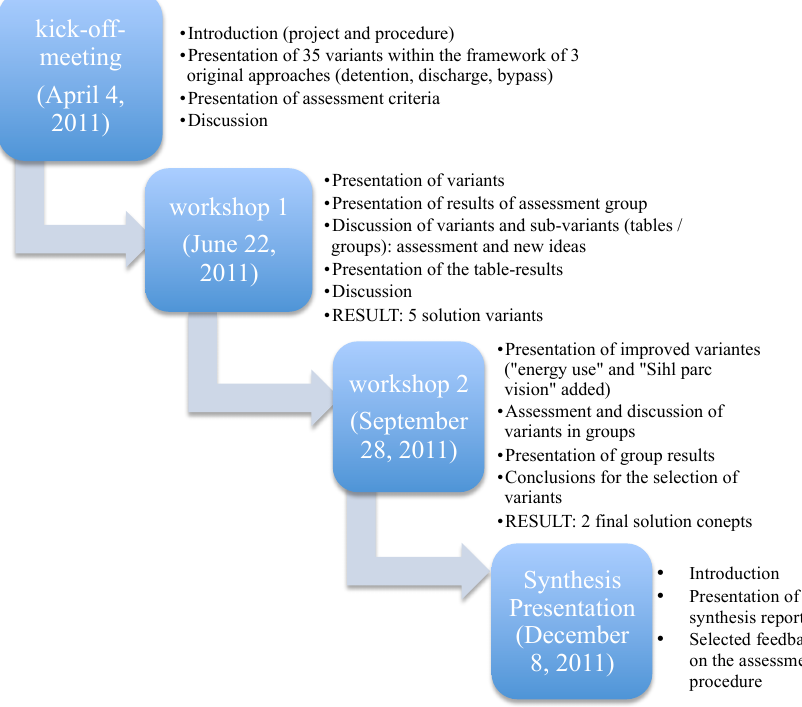
Fig. 3. Meetings and content of the process followed by the flood prevention project.